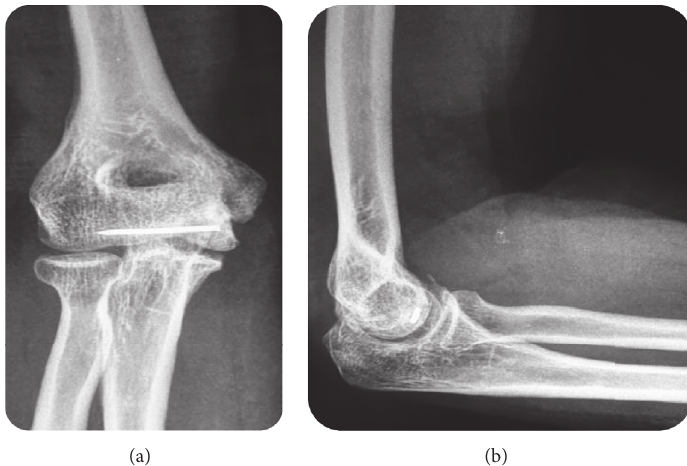
Figure6:TwoyearsafterfixationwithKirschnerwires:anteroposteriorview(a)andlateralview(b)showingboneunionwithoutdegenerative